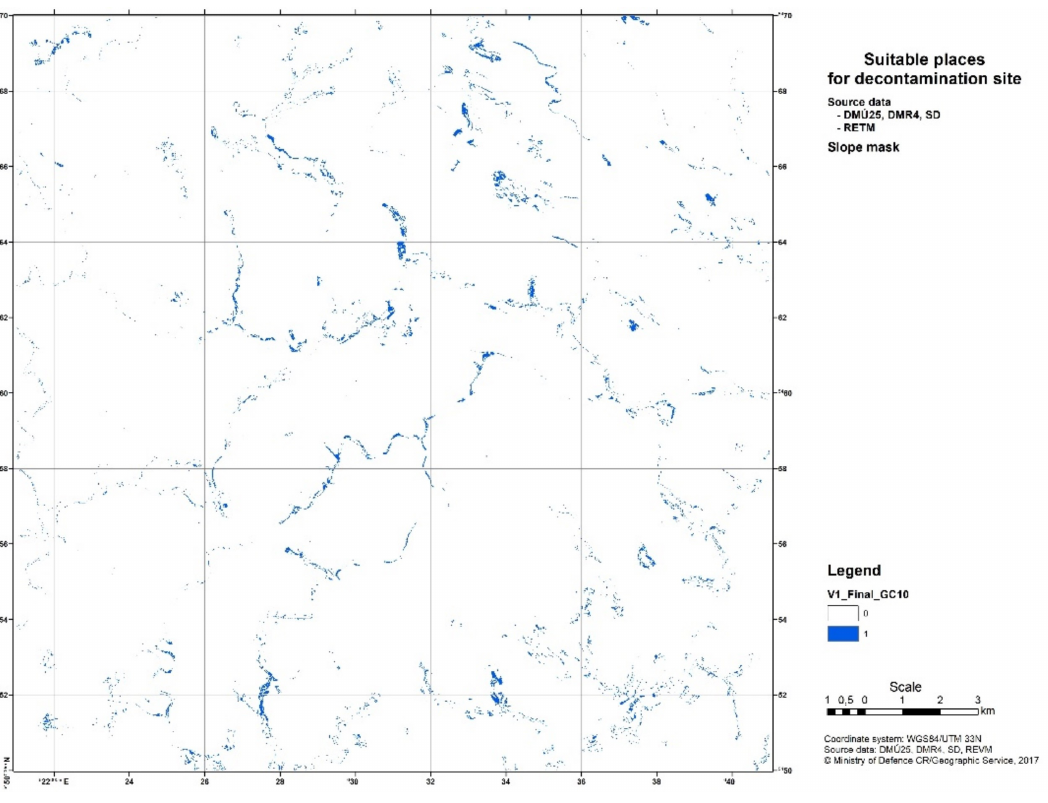
Figure 7. Intersection distribution of the same suitability values for the value 10 in the Jedovnice AOI